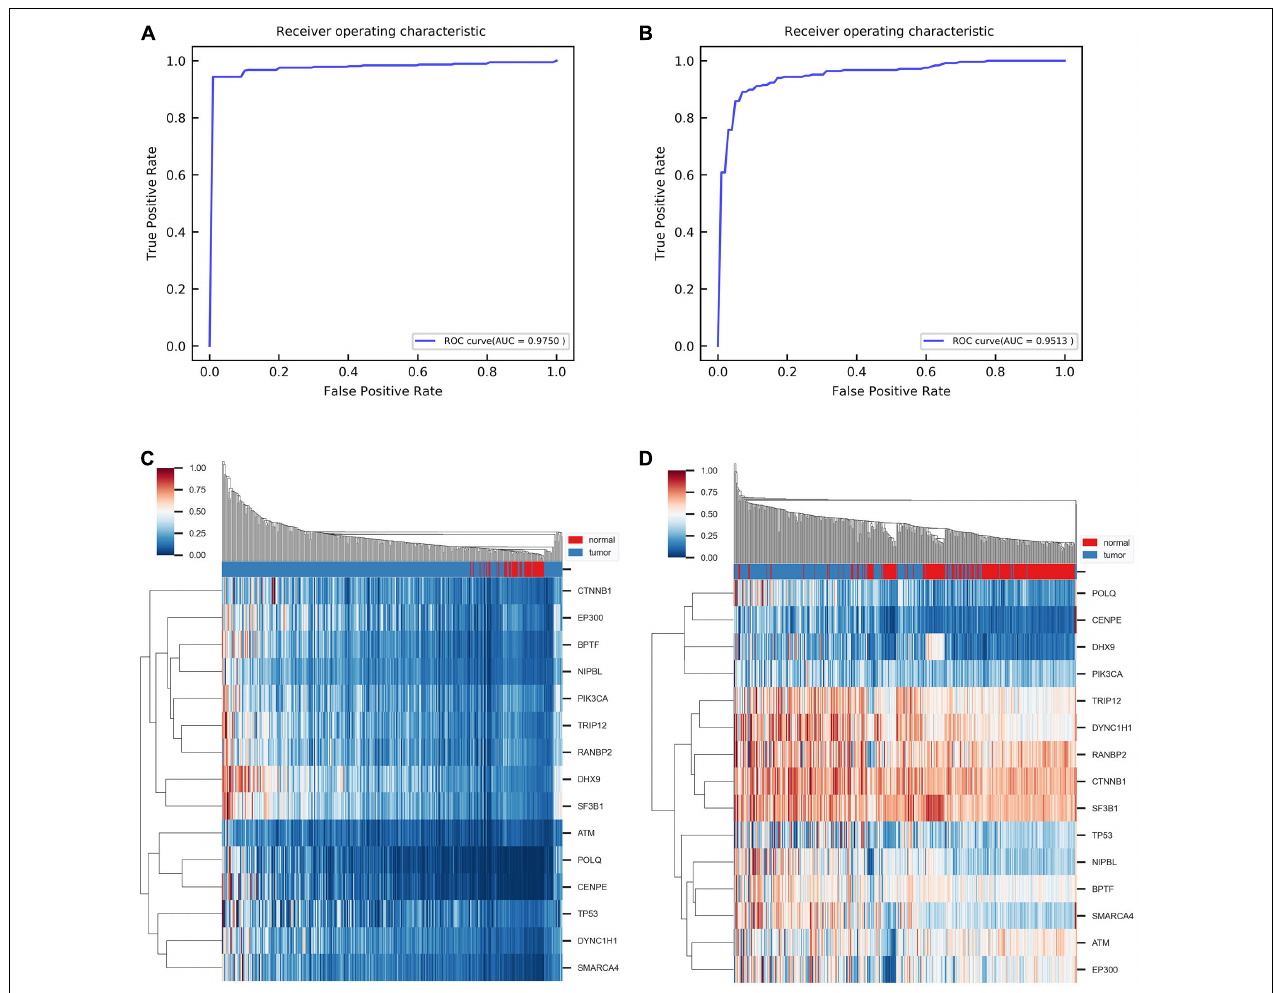
FIGURE 4 | Results of classification and clustering with identified disease-related genes. (A) ROC curve obtained from classification between tumor and normal group using fivefold cross-validation. ROC, receiver operating characteristic. AUC, the area under the curve. (B) ROC curve obtained from classification between tumor and normal group with independent dataset GSE14520. (C) Heat map of hierarchical clustering with single linkage and cityblock distance. (D) Heat map of hierarchical clustering with the same parameter in independent dataset